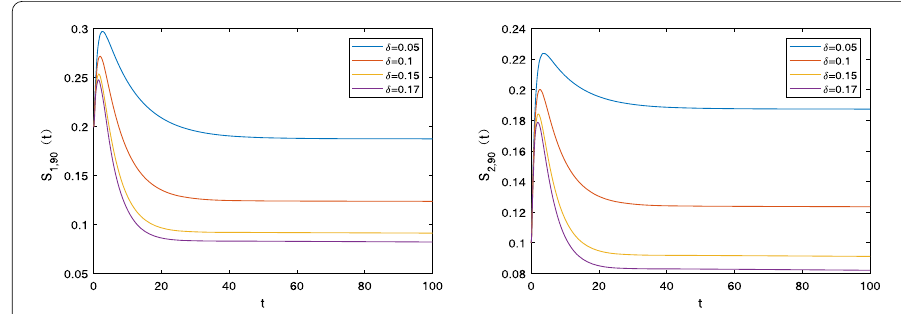
Figure 8 The densities of S 1,90 ( t ) and S 2,90 ( t ) with different values of δ